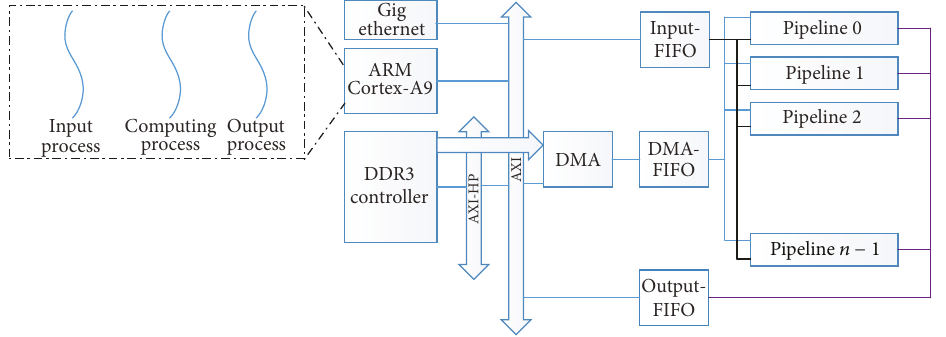
Figure 11: Protocol’s software